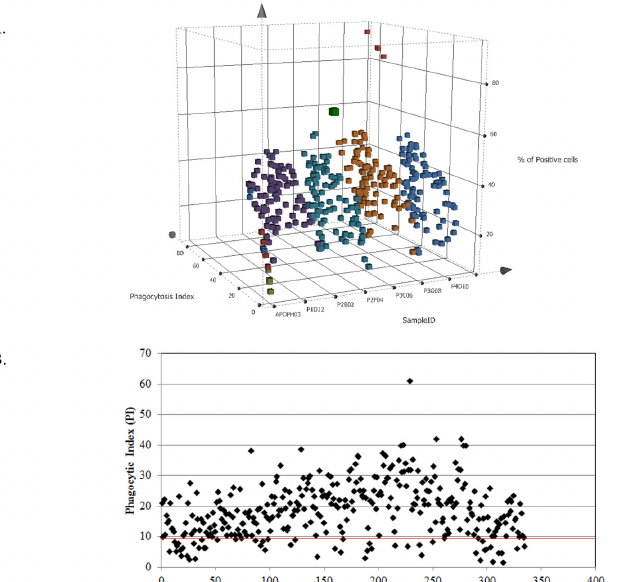
Fig 7. Monoclonal antibodies capable of modulating efferocytosis are identified using high content image-based screening. Purified hybridoma supernatants were tested in a 384-well format using day 7 M Φ ’ s co-cultured with apoptotic Jurkat cells then analyzed on the Operetta High Content Imager. Results are expressed as PI (z-axis) and % positive cells (y-axis) for each sample (A) with controls represented as follows: cytochalasin D treated M Φ ’ s with apoptotic cells negative control (green squares); live cell, baseline phagocytosis (dark red squares); apoptotic cells with no antibody (blue squares); dexamethasone treated M Φ ’ s with apoptotic cells positive control (orange squares). Samples from each plate are grouped and represented by colored squares. The antibody panel contains molecules that exhibit positive and negative effects on M Φ efferocytosis as revealed by comparison of PI of treated cells to controls (B). Each diamond represents the PI data from an individual hybridoma and each is compared to the PI of M Φ ’ s incubated with apoptotic cells in absence of antibody (red line) which is geometric mean of 4 replicates 9.995 ± 7.54. Data shown are from testing antibodies on macrophages from a single donor, a second assay using cells from a different donor was also performed yielding similar